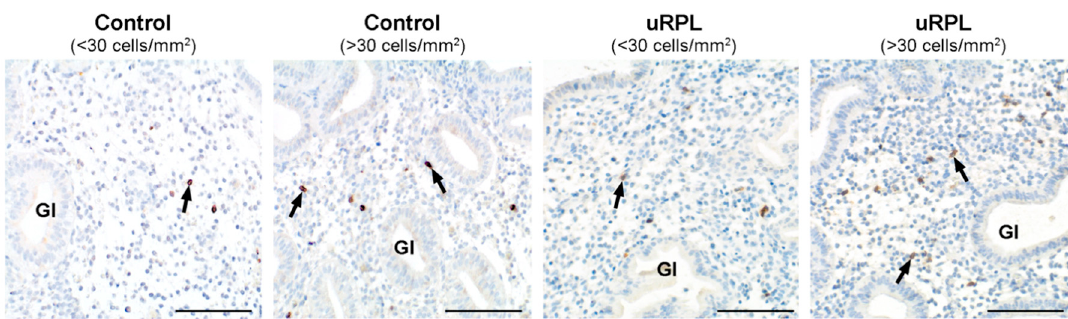
Figure 4. Immunohistochemical localization of CD57 + cells (arrows) in the endometrium of control ( < 30 and > 30 cells / mm 2 ) and uRPL cases ( < 30 and > 30 cells / mm 2 ). Gl: endometrial glands. Scale bar = 100 μ m.